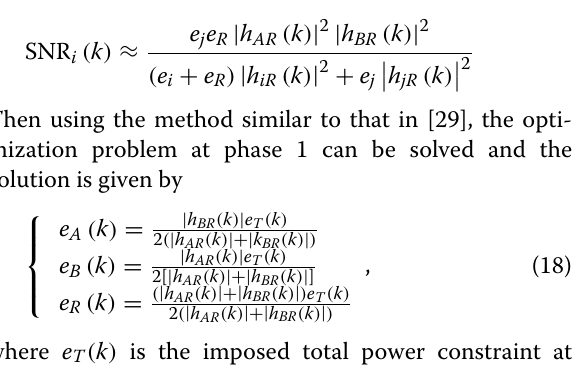
worth-mentioning that in [29], exact SNR expressions of the two sources are used to solve the optimization problem. For the sake of simplicity, here, the approximate SNR expression as given below is used